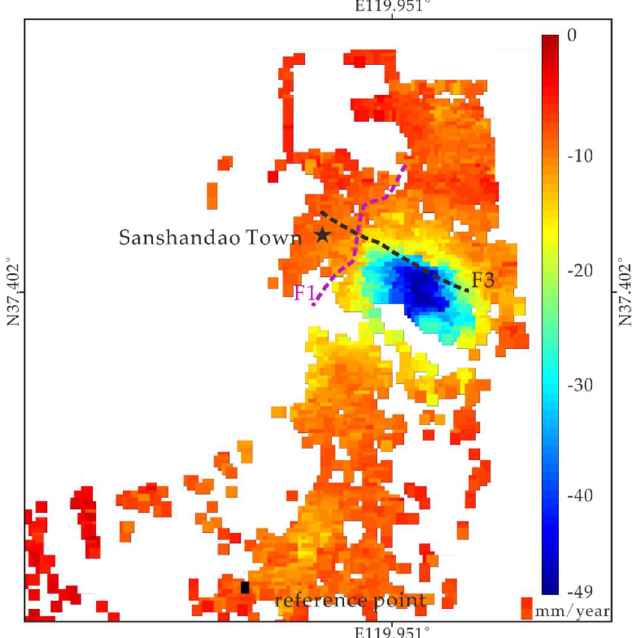
Figure 5. InSAR LOS velocity in study area between 22 February 2018 and 25 May 2021, processed using the PSI technique. Ground movements away from the satellite are shown with warm colors.